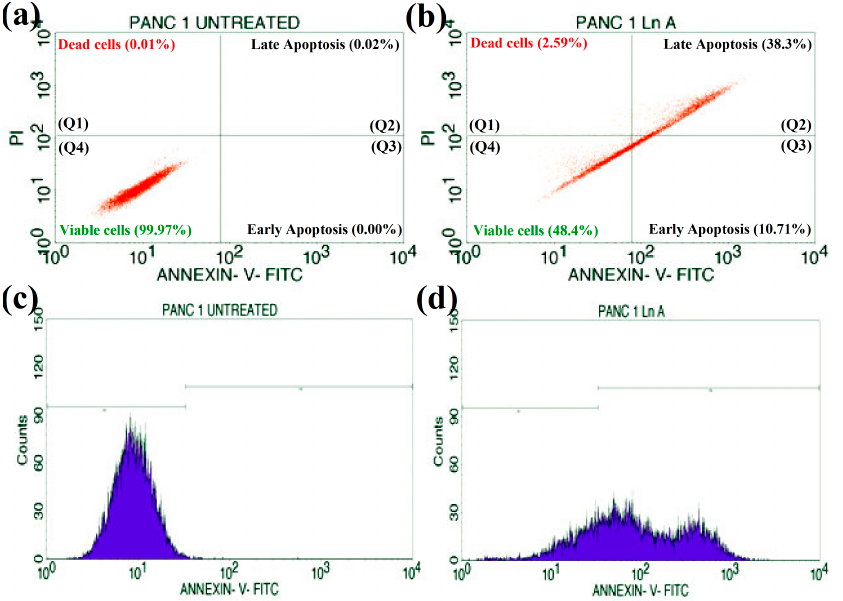
Figure 14. Quadrangular plot representing the Annexin V/PI expression in PANC-1 cancer cells: ( a ) untreated cells, ( b ) cells treated with LnFb-AgNPs, ( c ) cell cycle analysis of untreated cells, and ( d ) cells treated with LnFb-AgNPs analyzed by using flow cytometry.